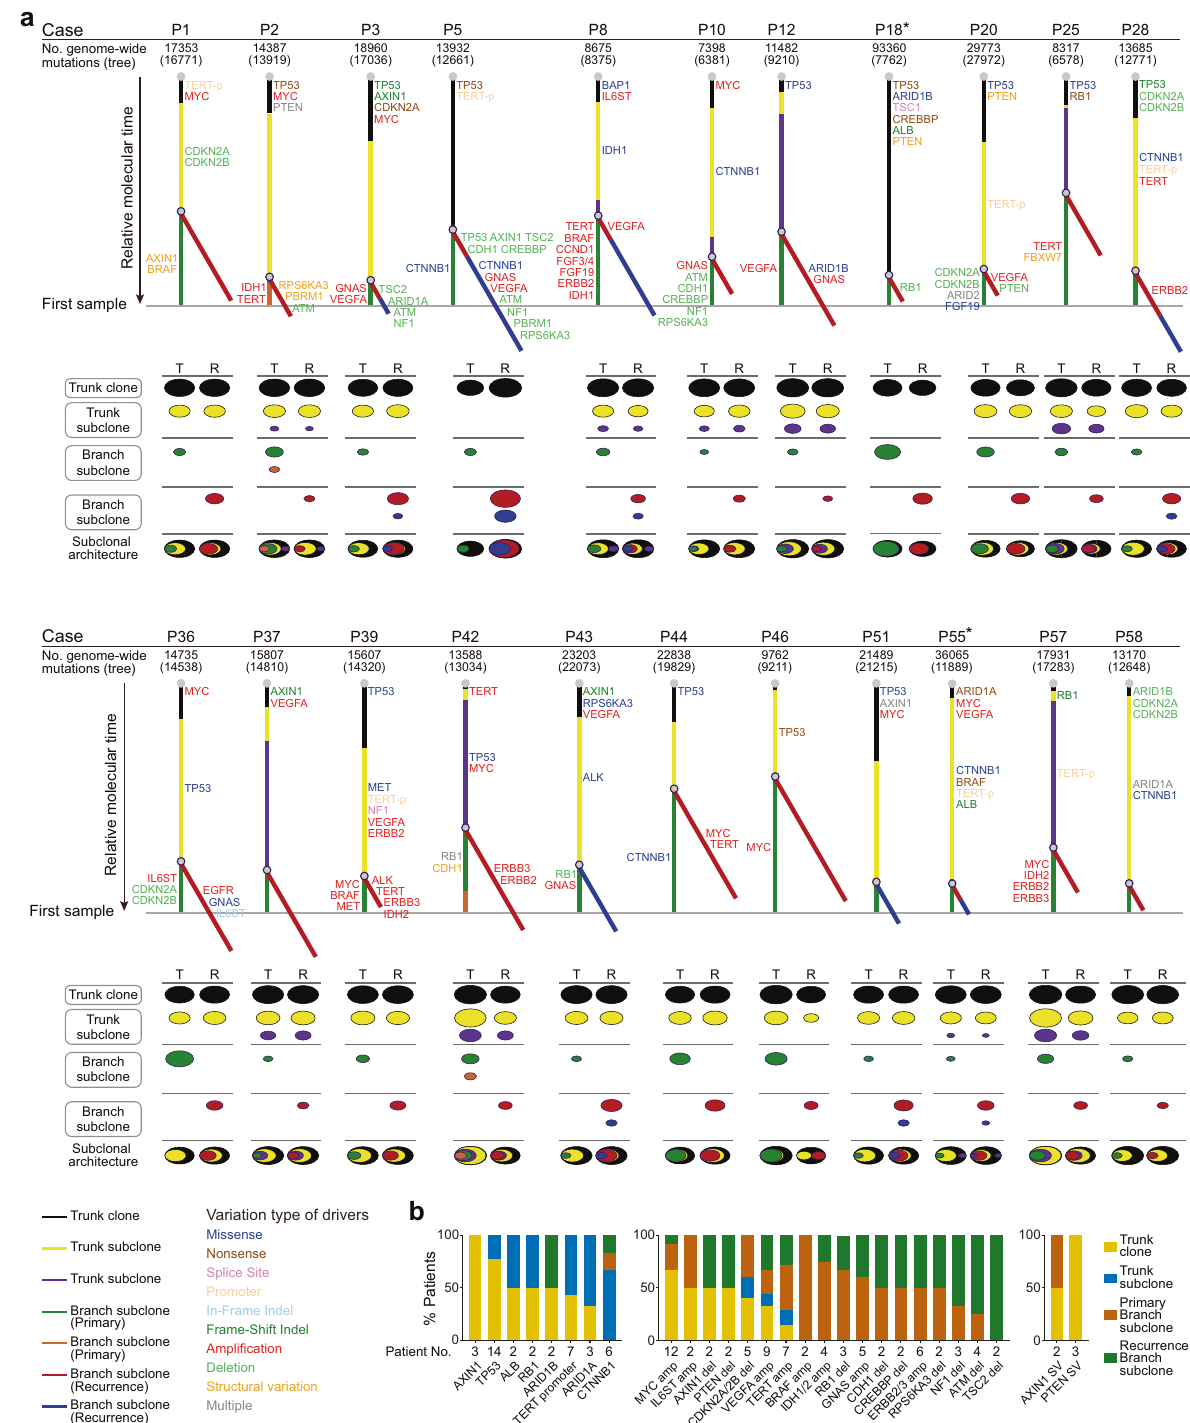
Fig. 3 Phylogenetic trees and subclonal architectures underlying the evolutionary trajectory of tumor early recurrence in 22 HCCs with ancestral recurrence. a Each tree and corresponding subclonal architecture represents an individual patient. Trees were derived from genome- wide somatic mutations (SNVs + indels) based on subclonal architectures. The numbers of all somatic mutations per patient are labeled above the tree (the numbers of somatic mutations involved in constructing the phylogenetic trees are labeled in brackets). The asterisk indicates that trees and subclonal architectures were derived from somatic mutations in genic region. Line lengths re fl ect the proportion of clustered somatic mutations attributed to that clone or subclone. The whole tree is scaled to the maximum length of a tree that would be inferred from mutations identi fi ed in the primary tumor. In the subclonal architecture panel, the diameter of each oval with color is proportional to the estimated CCF, which re fl ects the proportion of cells in that sample that contain the mutations that constitute the same color of the relevant phylogenetic tree. b The relative fraction of patients in whom the indicated somatic alterations of drivers occupied the trunk clone, trunk subclone, or branch subclone of their respective phylogenetic trees. The numbers of patients with each of the indicated somatic alterations are